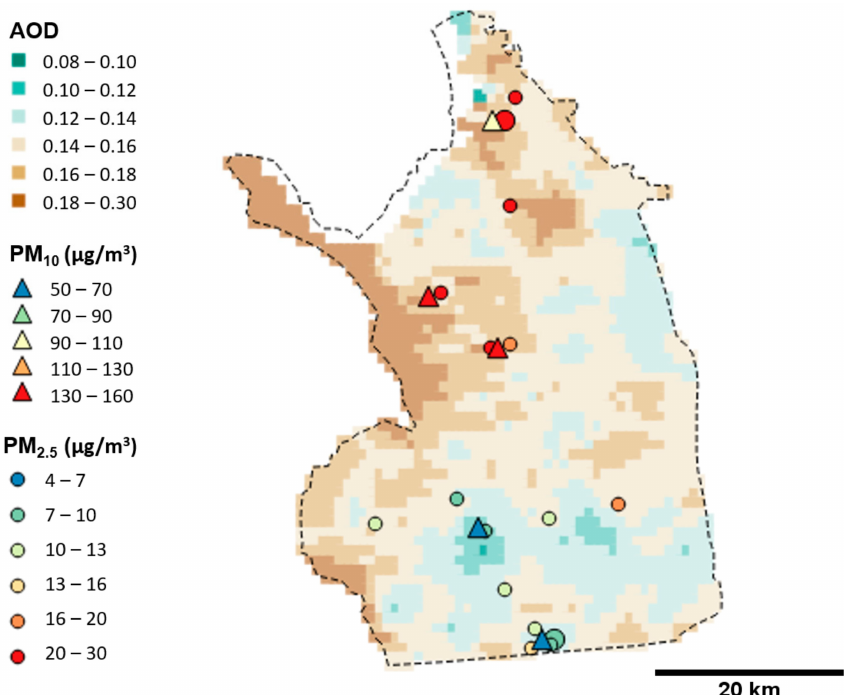
Figure 8. Average MAIAC AOD fields for the WSW set during 2016 ( n = 11, see Table 2) overlaid with ground PM concentrations from routine PM10 sites ( large triangles ), routine PM2.5 sites ( large circles ), and IVAN PM2.5 sites ( small circles ). Plotted PM10 and PM2.5 concentrations are averages of available measurements over the period at hour encompassing Aqua satellite overpass